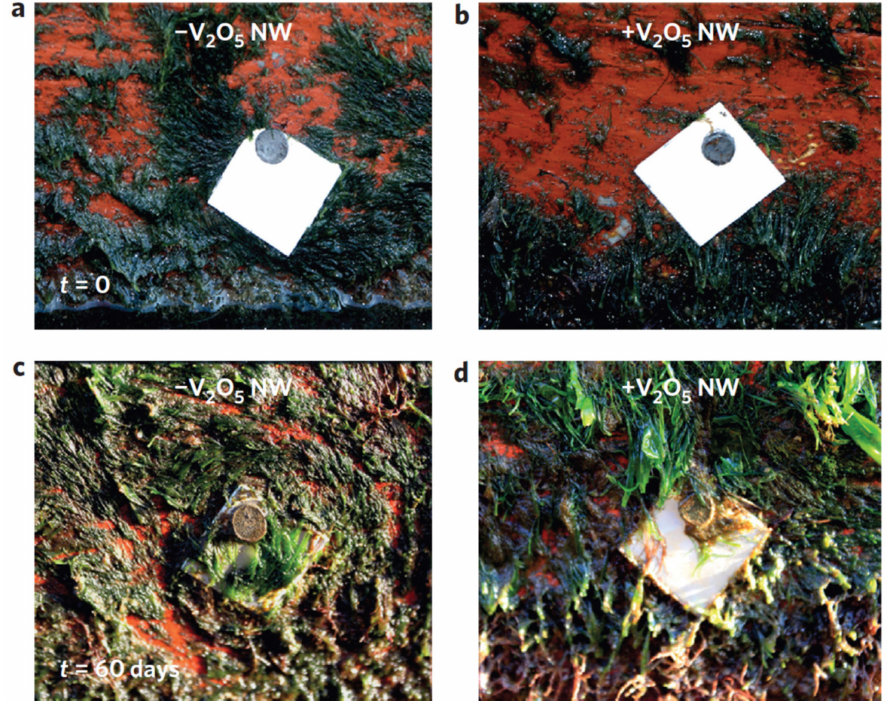
Figure 4. Effect of nanowires on biofouling in situ observed by Natalio et al. (Reproduced from [84], published by Springer Nature, 2012.) Digital image of a stainless steel plate (2 × 2 cm)